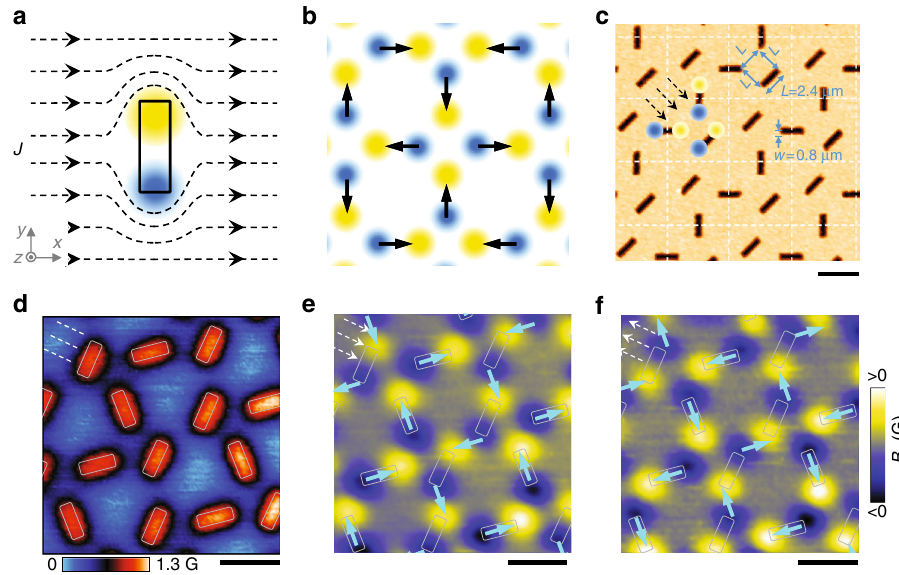
Fig. 1 Design and formation of the magnetic-charge-ice-like magnetic states. a Schematic view of a magnetic dipole generated by applying a current (indicated by dashed lines) around an elongated antidot. The yellow (blue) color indicates positive (negative) magnetic fi eld. b Schematics of magnetic charge ice ground state ordering. The arrows, pointing from negative (blue) to positive (yellow) charges and mimicking spins, form the ground state of arti fi cial square spin ice. c Atomic force microscopy image showing the topography of the sample. When applying a current in diagonal direction, the ground state magnetic-charge-ice-like pattern distribution can be observed in each square unit (5.8 × 5.8 μ m 2 ) separated by the dashed lines. d SHPM image of vortex pattern observed after fi eld cooling to 4.2 K at fi rst matching fi eld 1.23 Oe. White rectangles show the positions of antidots in the scanned area. The dashed lines, parallel to the nearest sample edge, indicate the direction along which Meissner current fl ows. e , f Scanning Hall probe microscopy images of magnetic dipole distributions corresponding to the twofold degenerate ground state of a magnetic charge ice. The images were observed after zero- fi eld cooling to 4.2 K and then applying magnetic fi eld of 4.5 Oe ( e ) or − 4.5 Oe ( f ).The dashed arrows indicate the directions of the induced Meissner currents. The rectangles mark the positions of antidots. The solid arrows show the ground state of a square spin ice. All scale bars, 4 μ